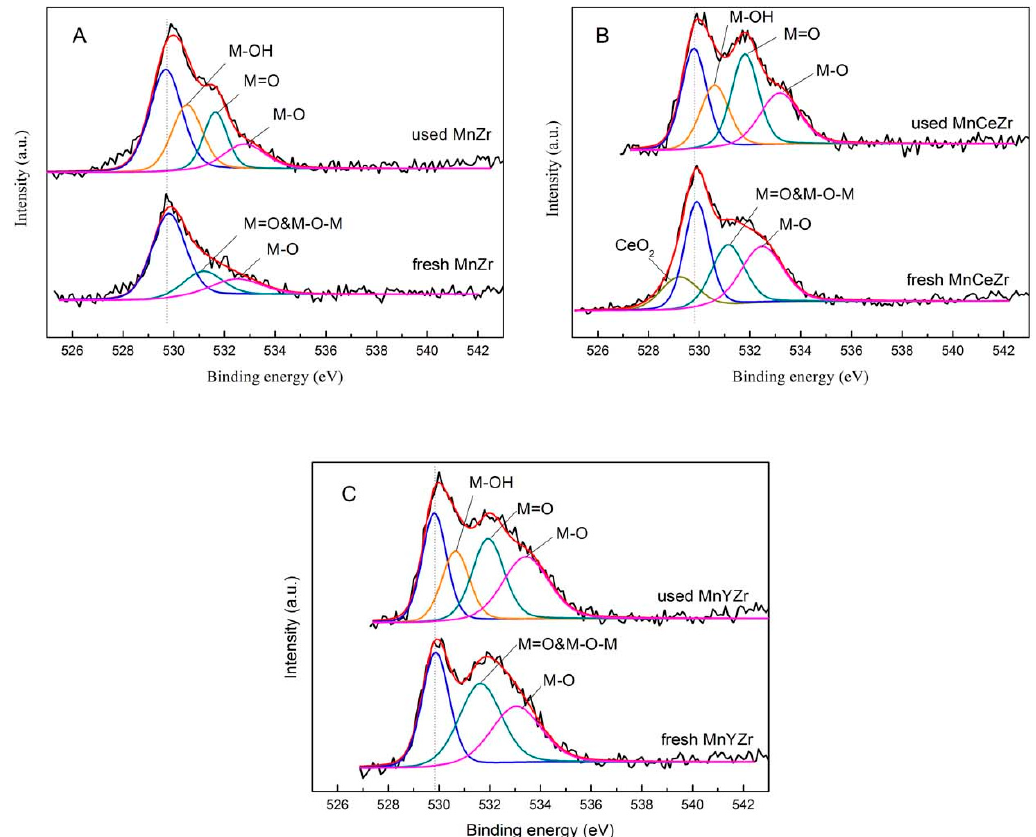
Figure 7. O 1s XPS spectra of catalysts before and after the reaction in the presence of SO 2 . ( A ) MnZr; ( B ) MnCeZr; and ( C ) MnYZr. M: Surface metal or sulfur. ( B ) MnCeZr; and ( C ) MnYZr. M: Surface metal or Table 2. Proportions of different O species obtained by the peak fitting of the O 1s curves.